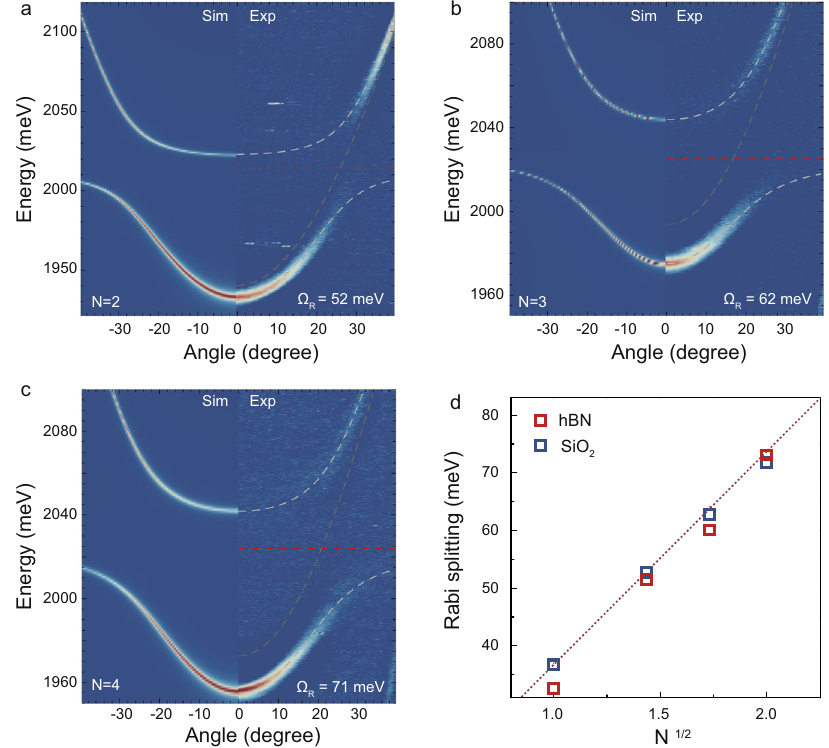
Fig. 2 | Exciton-polaritons formation in superlattice microcavity. Angle- resolved re fl ectivity maps for the superlattice-N2 ( a ), -N3 ( b ), and -N4 ( c ), respec- tively (with SiO 2 insulating spacer). The left (right) part of the fi gures shows the TMMcalculations(experiments).ThetwodashedwhitecurvesaretheUPBandLPB dispersions obtainedby using a coupled oscillator model.The dashedred line and